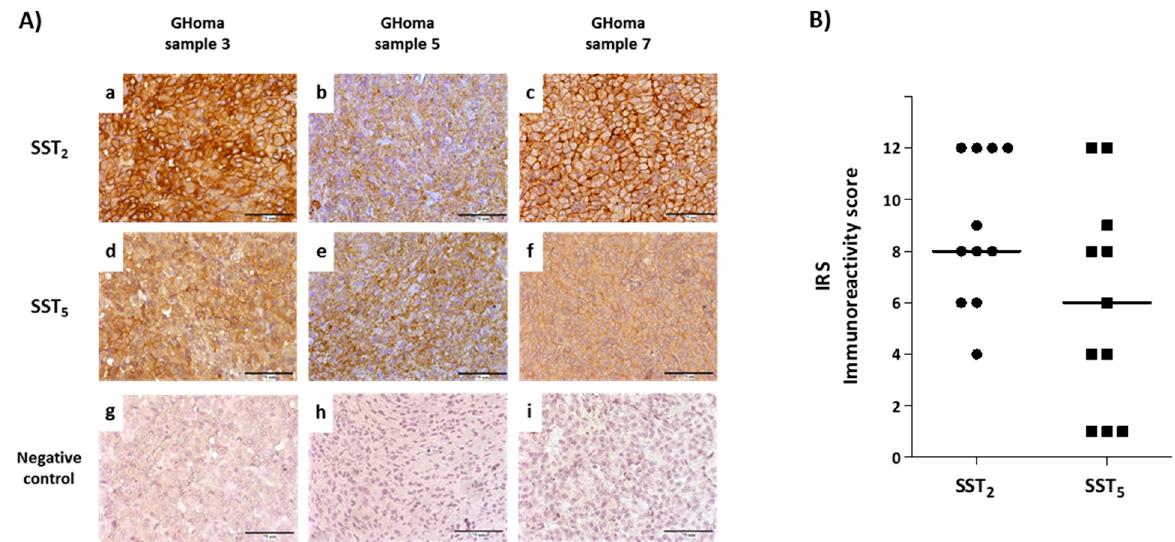
Figure 1. Immunohistochemical evaluation of SST 2 and SST 5 in somatotroph pituitary tumors. Panel ( A )) Representative IHC of SST 2 and SST 5 in three different GHomas (scale bar, 75µm): ( a ) high SST 2 IRS in sample 3 (IRS 12); ( b , c ) high- intermediate SST 2 IRS in samples 5 and 7 (IRS 8); ( d ) high-intermediate SST 5 IRS in sample 3 (IRS 9); ( e ) high SST 5 IRS in sample 5 (IRS 12); ( f ) intermediate SST 5 IRS in sample 7 (IRS 4); ( g – i ) negative controls processed with the omission of primary antibodies. Panel ( B )) Scatter plot of SST 2 and SST 5 IRS of all samples ( n = 11) and median line. Each dot and square in panel ( B ) represents a single patient.